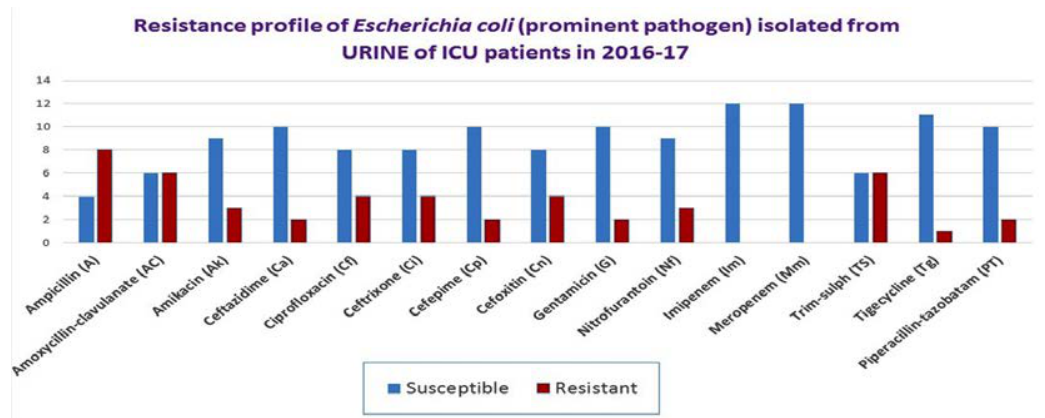
Fig. 3. Antimicrobial susceptibility trend of Klebsiella pneumoniae cultured from blood of ICU patients (2016-2017)